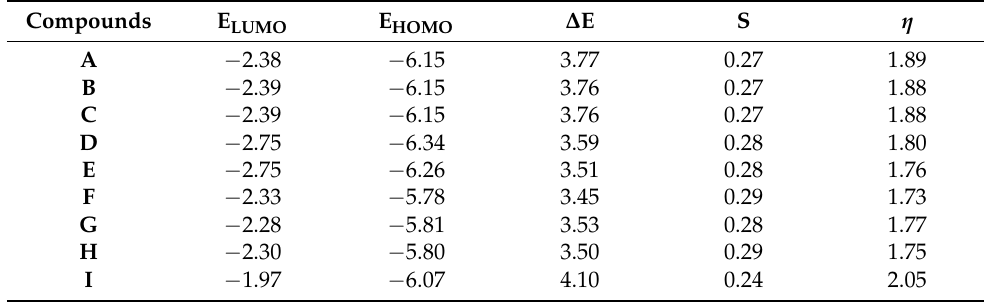
Table 5. The frontier molecular orbital energies (eV), global softness S , and chemical hardness η (eV) of A , B , C , D , E , F , G , H , and I